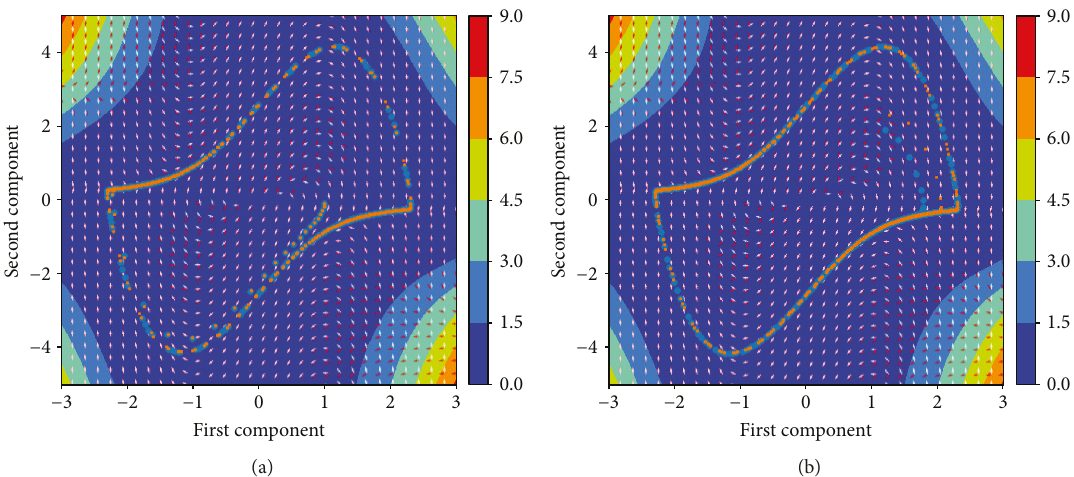
Figure 4: Stepwise error contour of the basic model on VDP case. (a) Training data. (b) Testing data. Blue dot: ground truth. Orange dot: prediction. White arrow: direction of target vector of ground truth. Red arrow: direction of target vector of prediction.